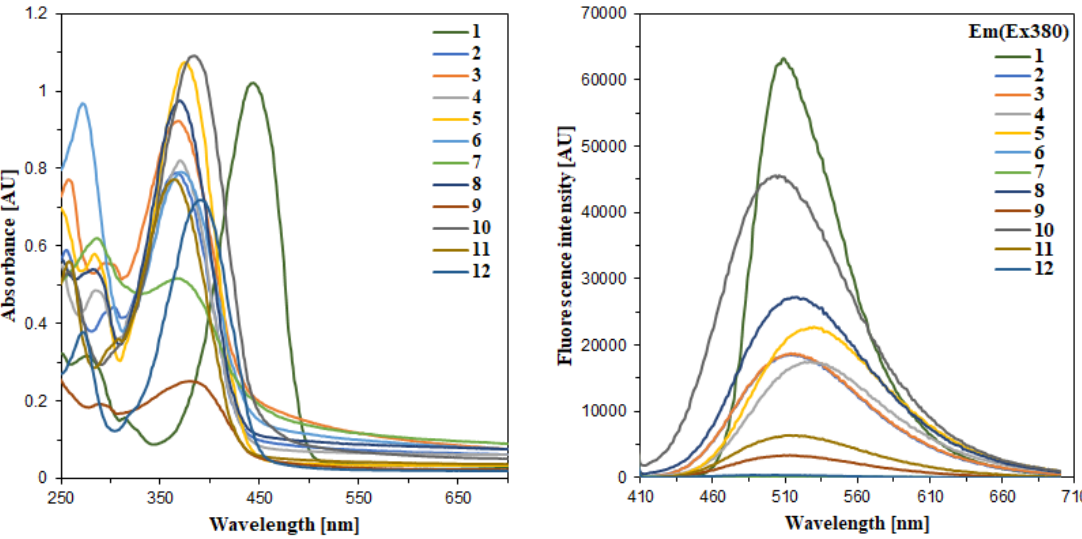
Figure 7. Electronic absorption ( left ) and fluorescence emission spectra ( right ) of coumarin–thiadiazole hybrids 1-12 recorded in methanol. The absorption spectra were recorded at a concentration of 0.2 mM, except 1 , which was recorded at 0.04 mM. The fluorescence spectra were recorded at λ ex = 380 nm and a concentration of 0.01 mM, except 1, which was recorded at λ ex = 420 nm and 0.002 mM, respectively.